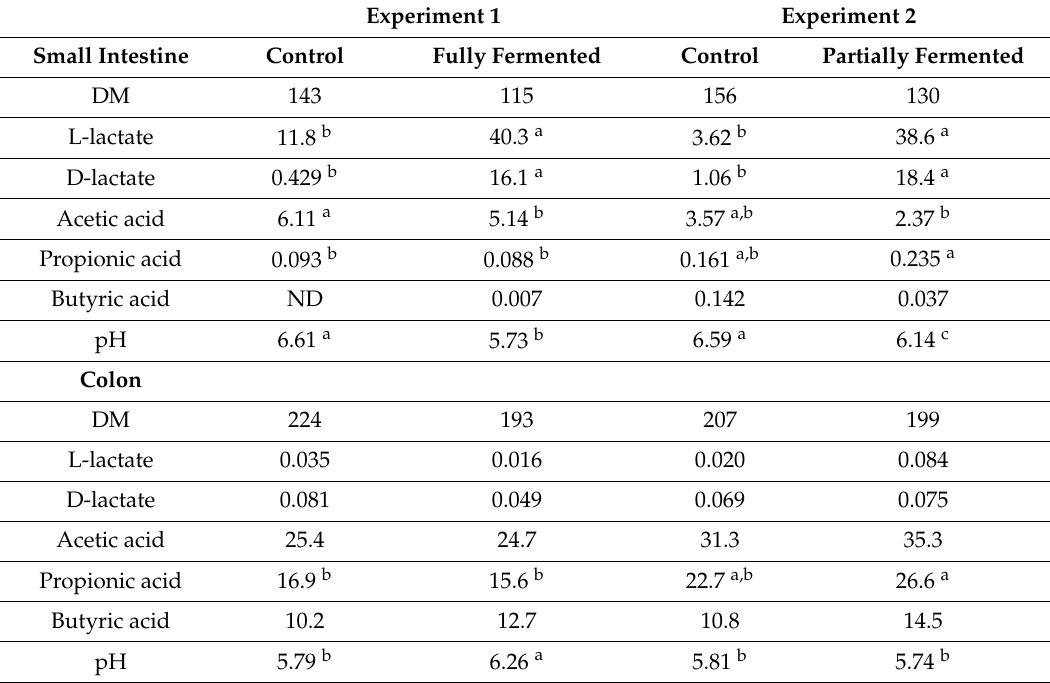
Table 5. Means of dry matter (DM, in g / kg fresh matter), l-lactate, d-lactate, volatile fatty acids (in g / kg DM) and pH in the digesta of the small intestine and colon depending on the dietary